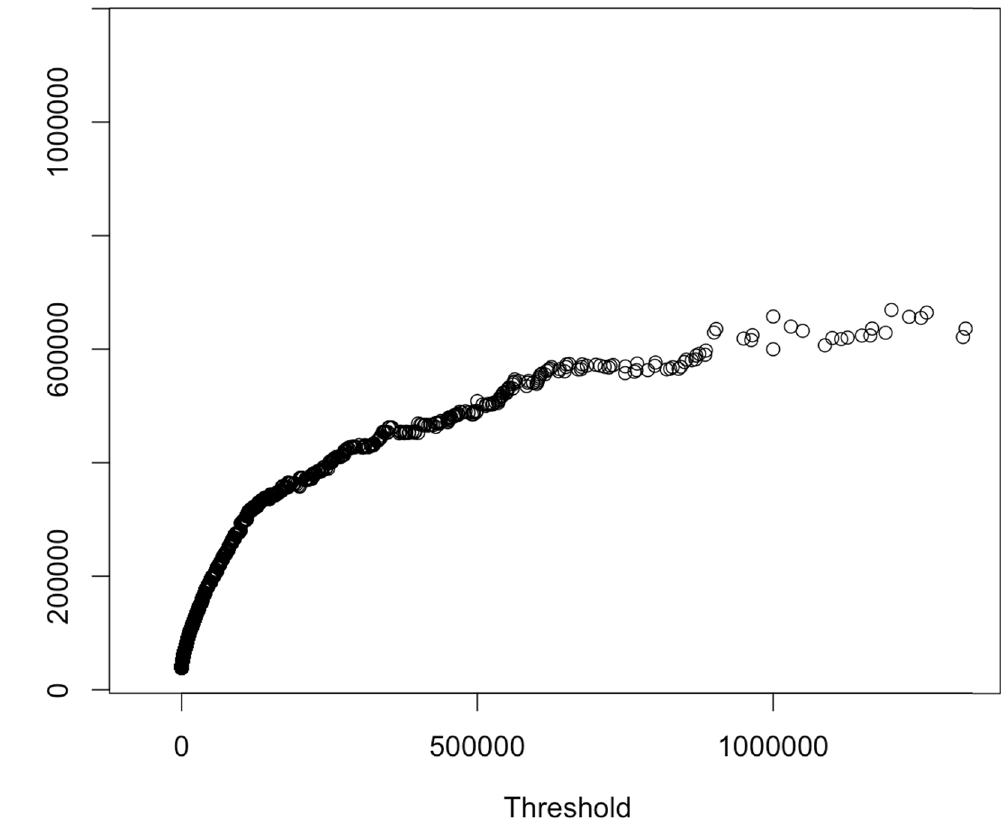
Fig 7. Mean Excess Function Plot. Mean excess function plot for the non-zero payments. Concavity is a symptom of lognormally distributed